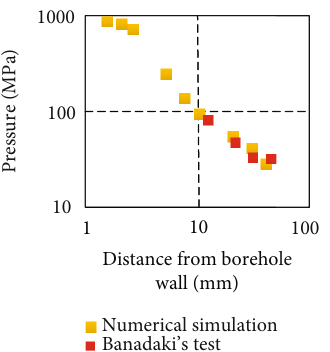
Figure 6: Experimental and numerical results of stress conditions at di ff erent locations from the blasting hole.